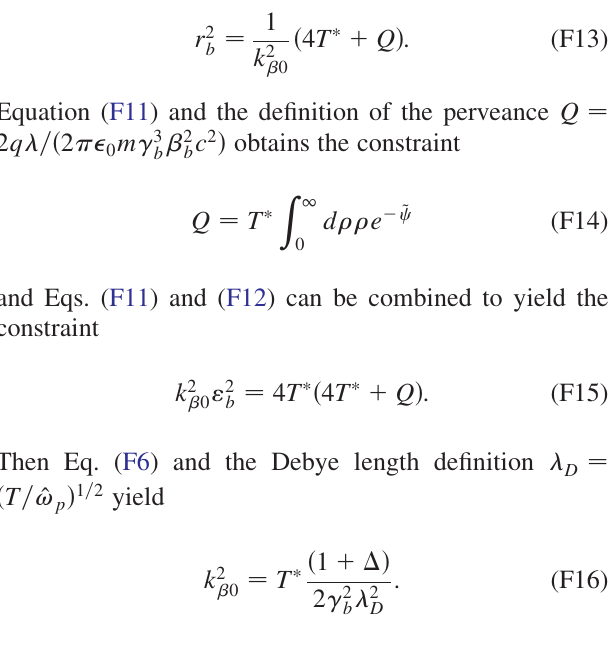
as calculated from 0